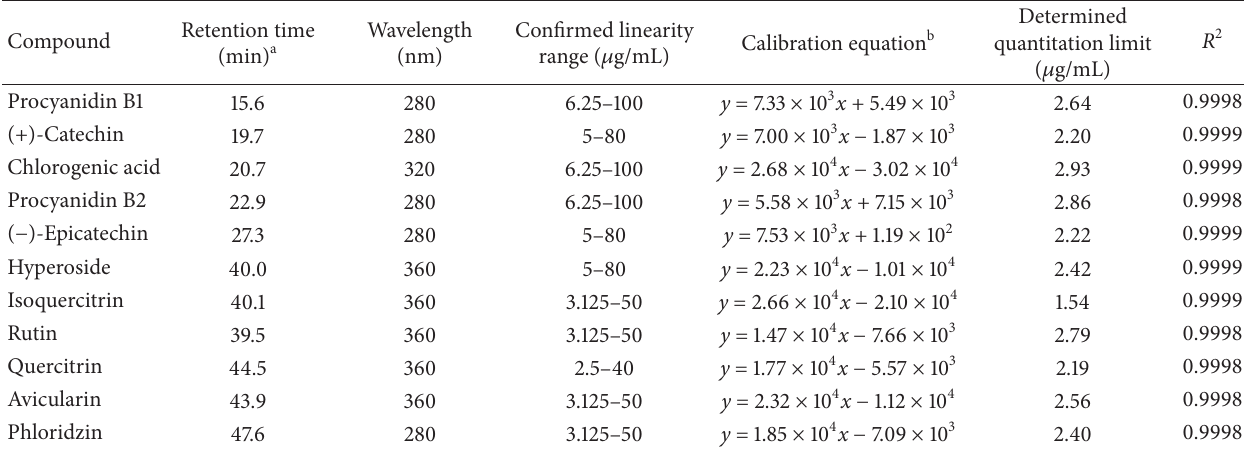
Table 1: Characteristics of the quantitative evaluation of phenolic